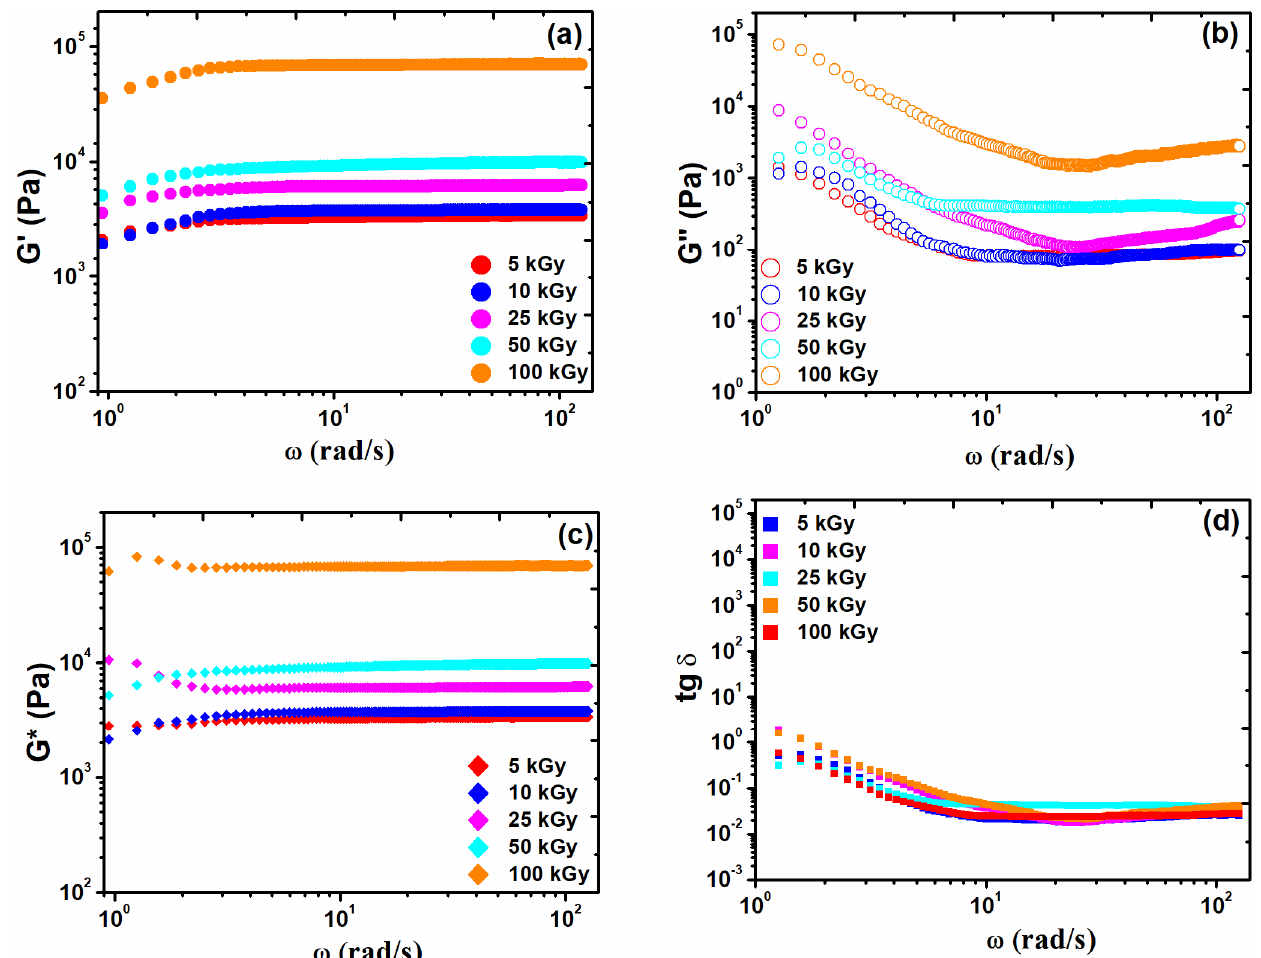
Figure 3. The variation of G’ ( a ), G’’ ( b ), G* ( c ), and tan δ ( d ) on the angular frequency ( ω ) and the absorbed dose, for the collagen hydrogel crosslinked.